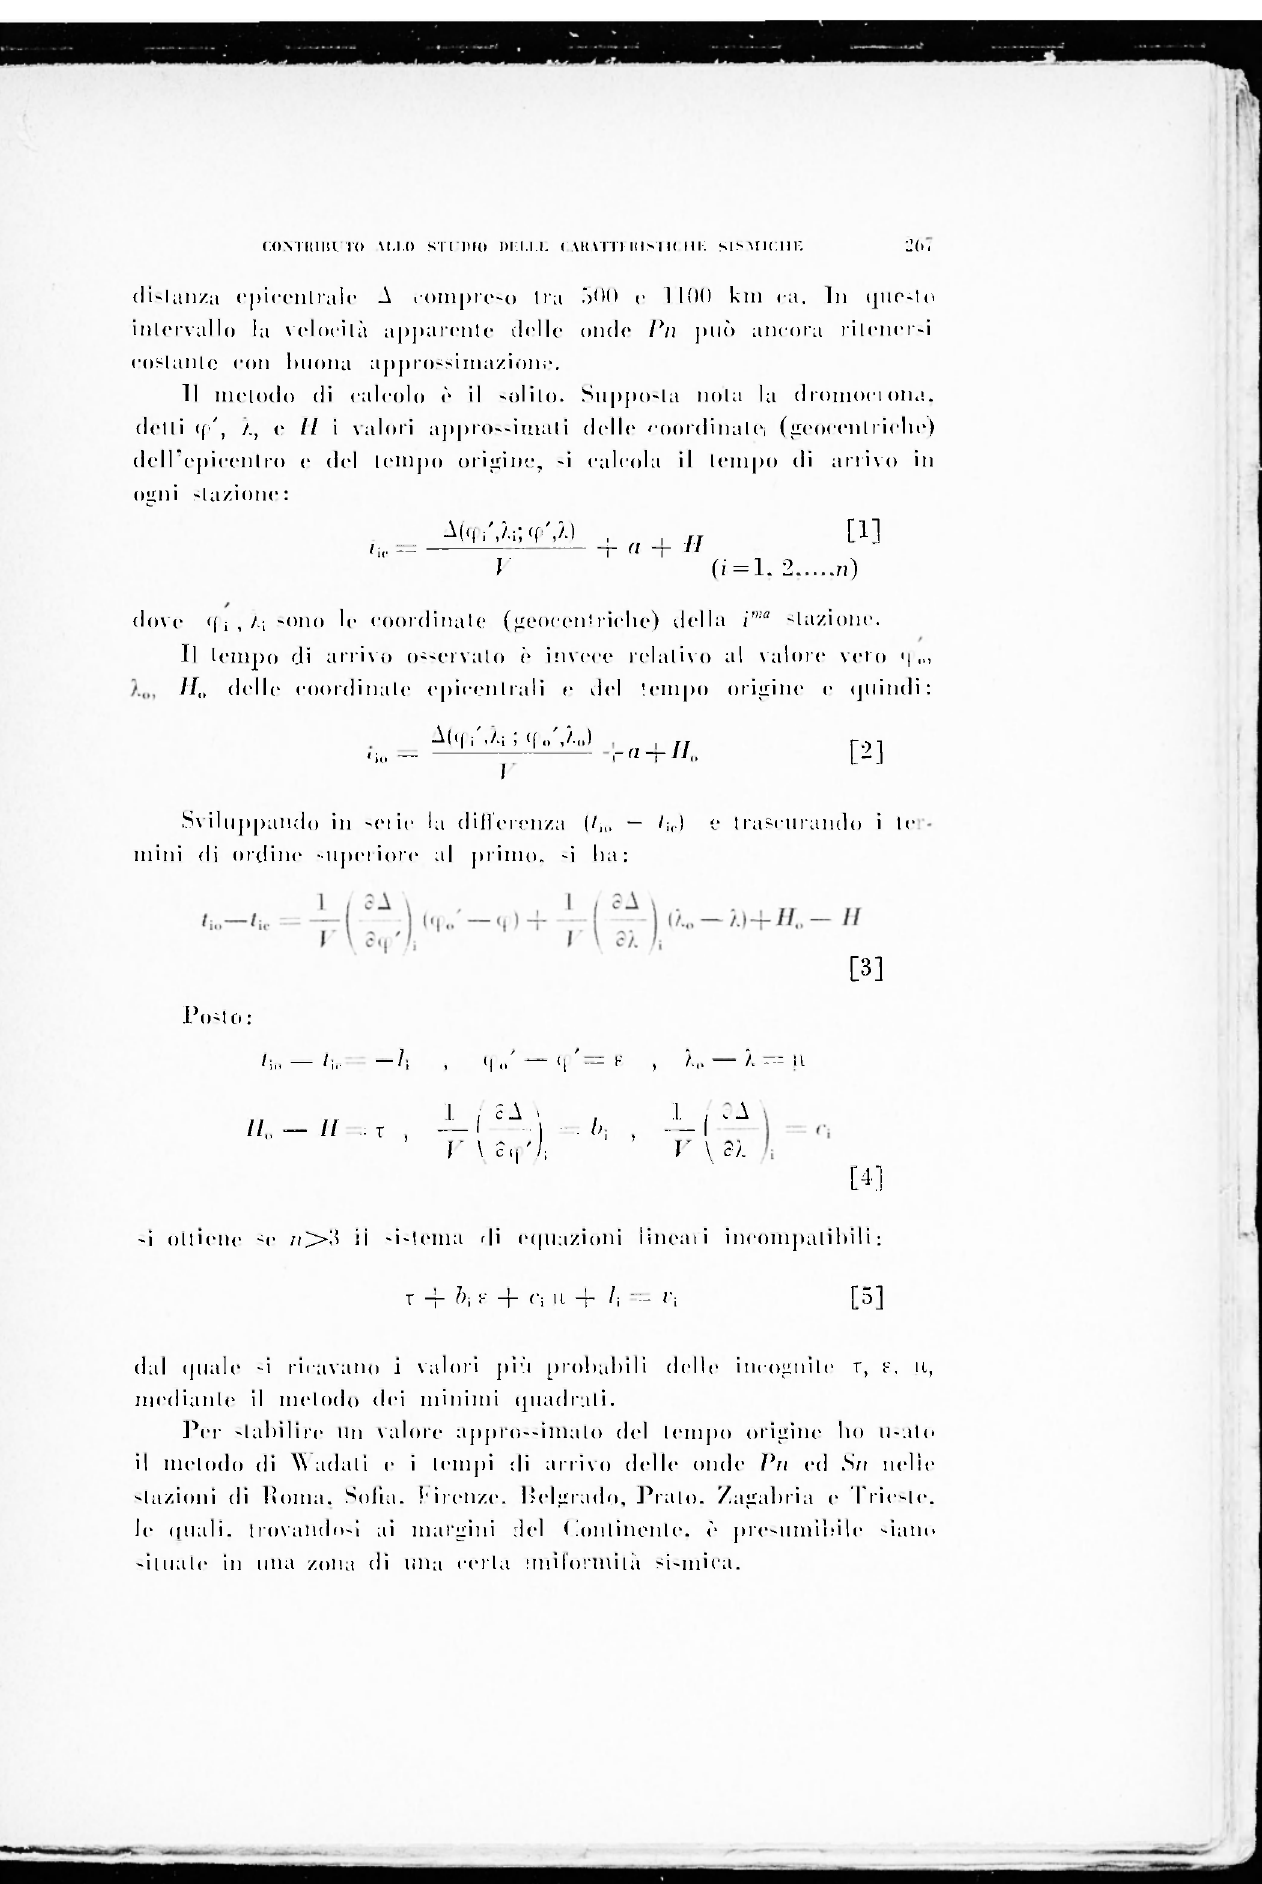
H.i delle coordinate epieentraii e del tempo origine e